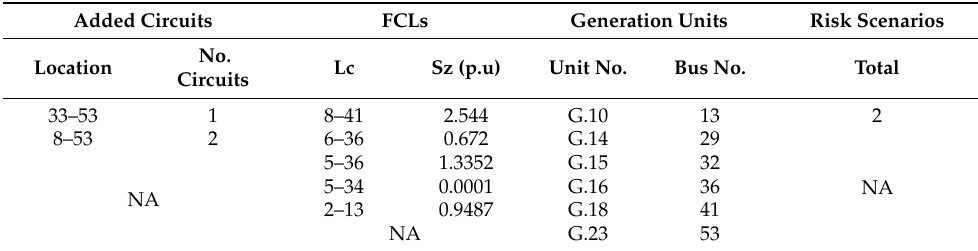
Table 3. Configuration of WDN for Scenario Number 24.